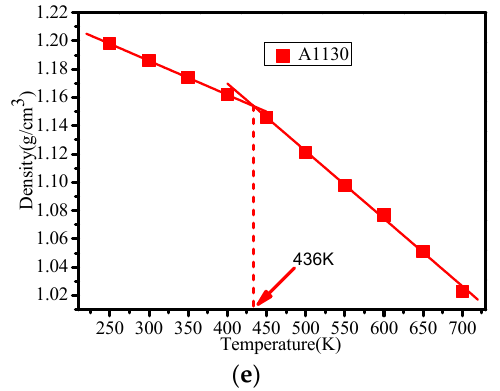
Figure 8. ( a ) The density-temperature fitting curve of the pure model; ( b ) the density-temperature fitting curve of the SiO 2 model; ( c ) the density-temperature fitting curve of the A1100 model; ( d ) the density-temperature fitting curve of the A1120 model; ( e ) the density-temperature fitting curve of the A1130 model.